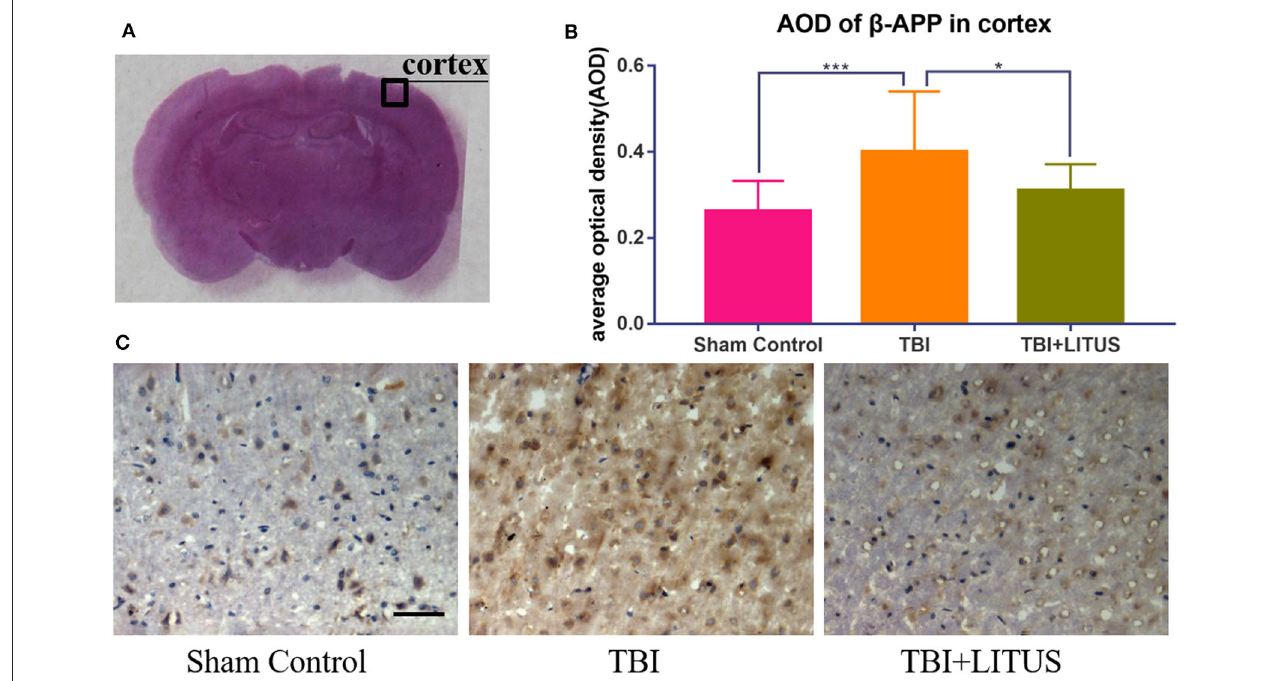
FIGURE 7 | Histopathology in the ipsilateral cortex at 42 days after TBI. (A) Representative images of β -APP stained neurons at injury cortex at 42 days after injury. (B) The AOD of rats in the TBI + LITUS group was 0.31 ± 0.06. The AOD for the TBI group was 0.4 ± 0.14, indicating LITUS can significantly promote the expression of β -APP. (C) Compared to sham control rats, the number of β -APP stained cells in the damaged cortex of the TBI group was significantly increased. The number of cell damage in the TBI + LITUS group was significantly less than that in the TBI group, which indicated that LITUS had a good neuroprotective effect. Bar, 50 µ m. Data are mean ± SD, n = 10. Tukey’s post-hoc test, * P < 0.05, *** P < 0.001.